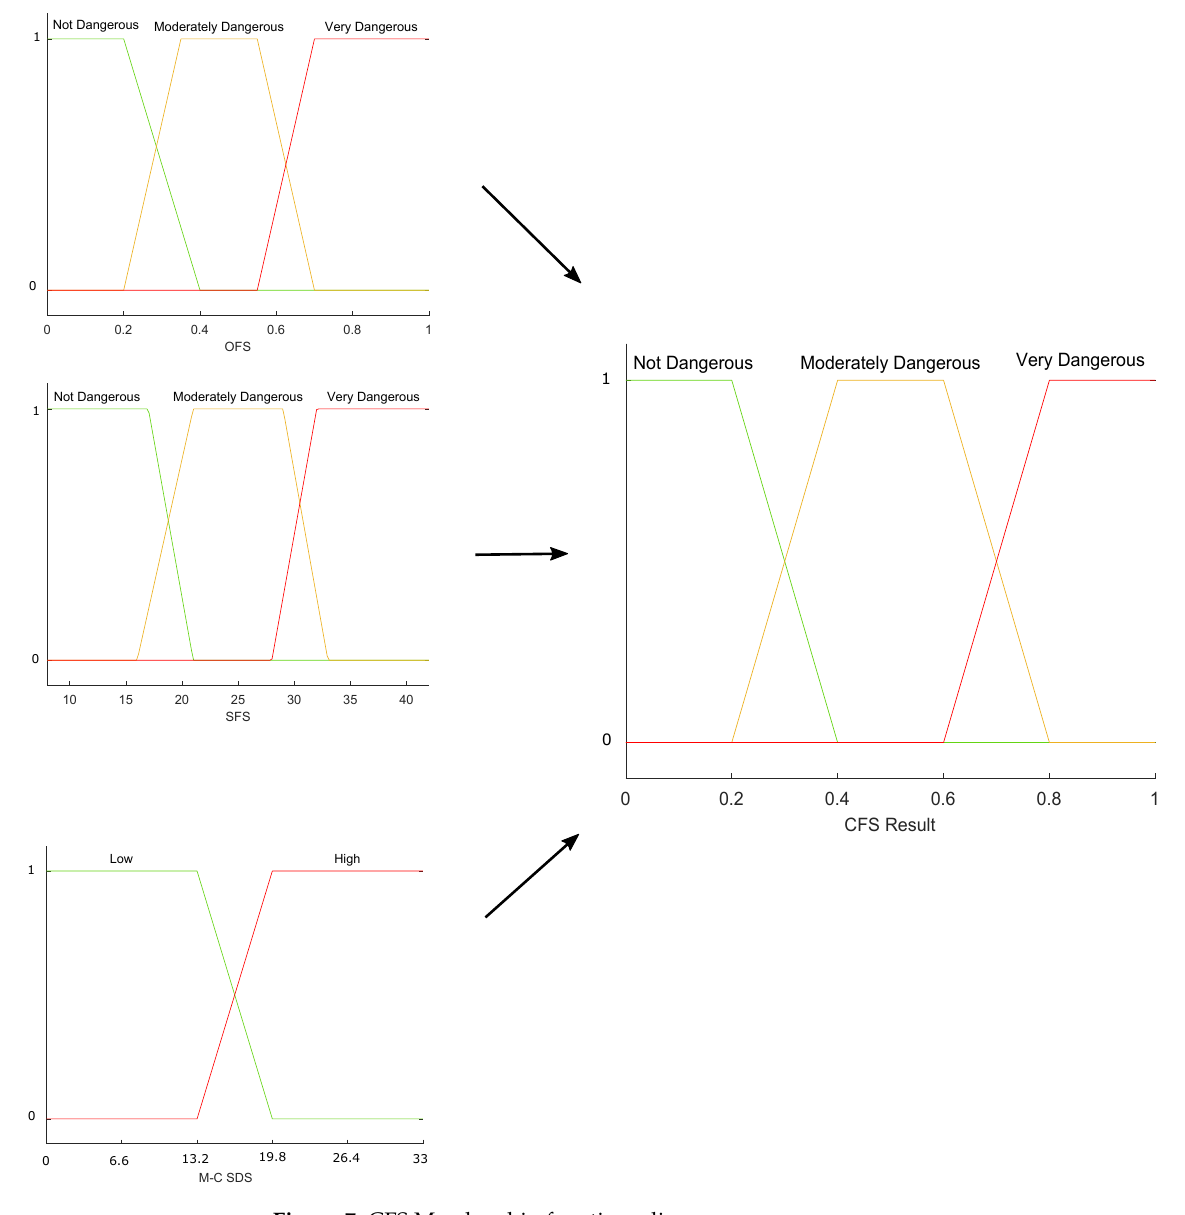
Figure 7. CFS Membership functions